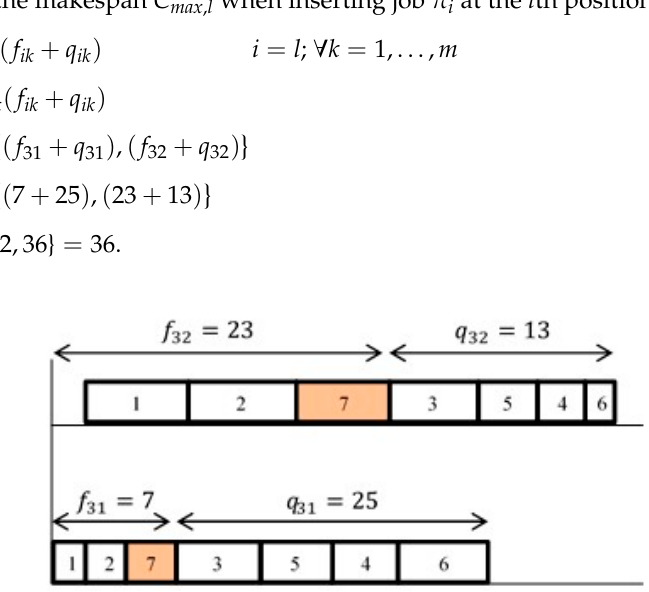
Figure 2. Speed-up calculation of a complete solution.